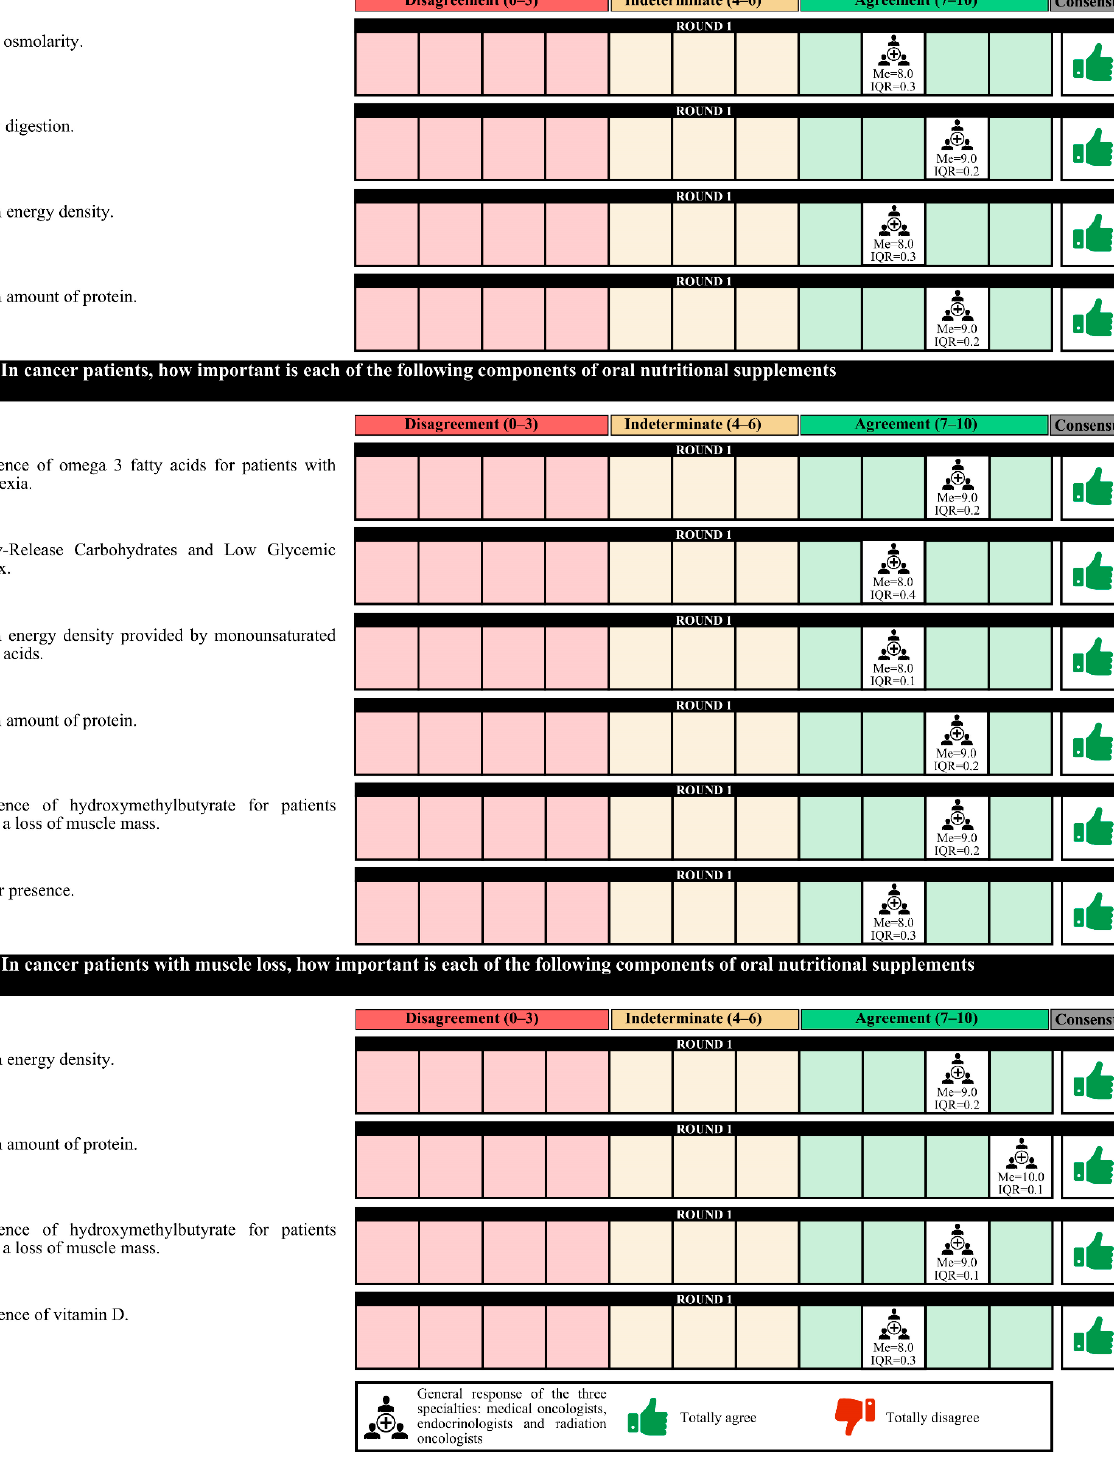
Figure 7. Answers about nutritional therapy (III). IQR, interquartile range; Me, median.